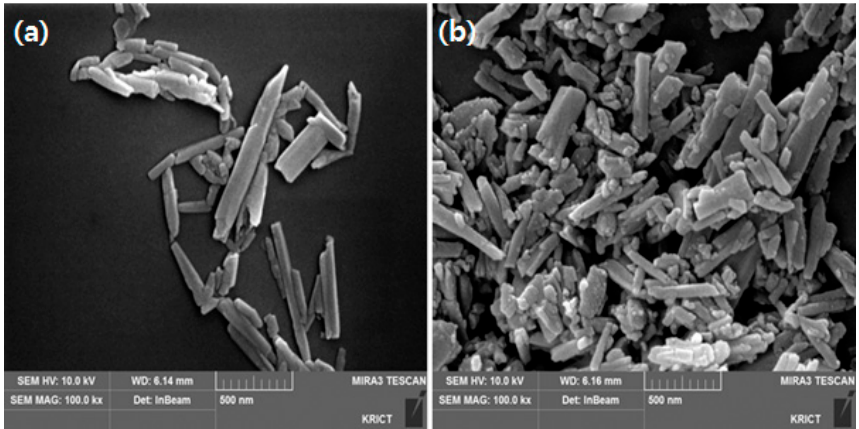
Figure 2. SEM images of ( a ) HNT and ( b ) Zr/HNT.